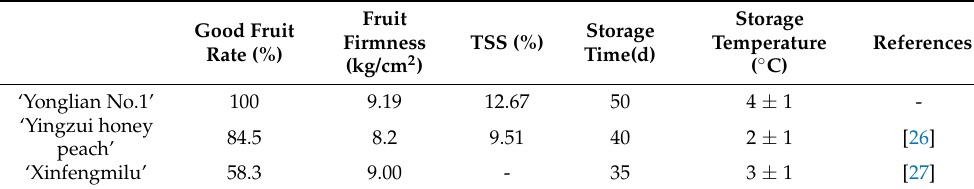
Table 1. Storage quality index of different peach varieties.